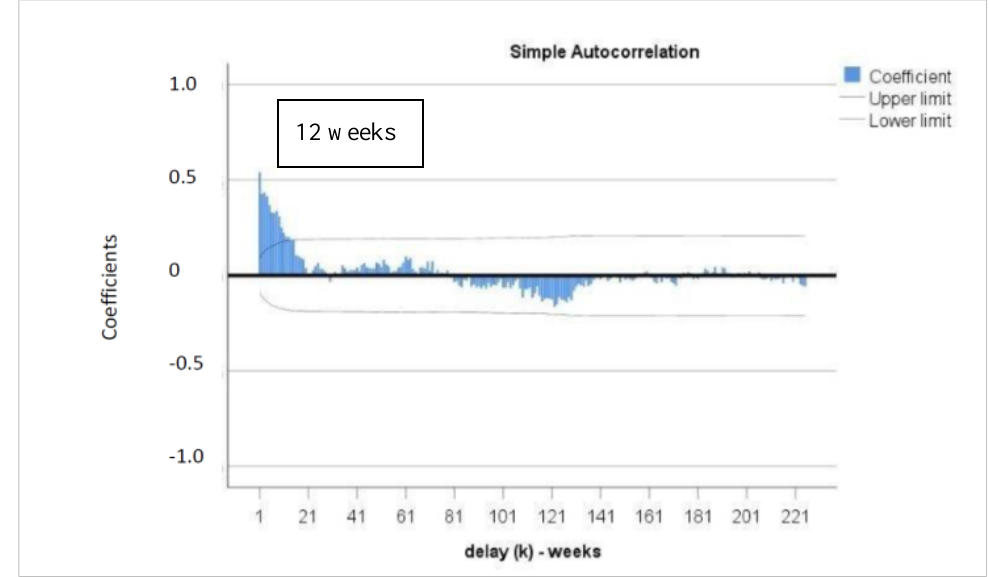
Figure 4. Representation of the simple autocorrelation test. The two lines indicate the confidence interval of 95%, and the bars are the coefficients of the analysis.